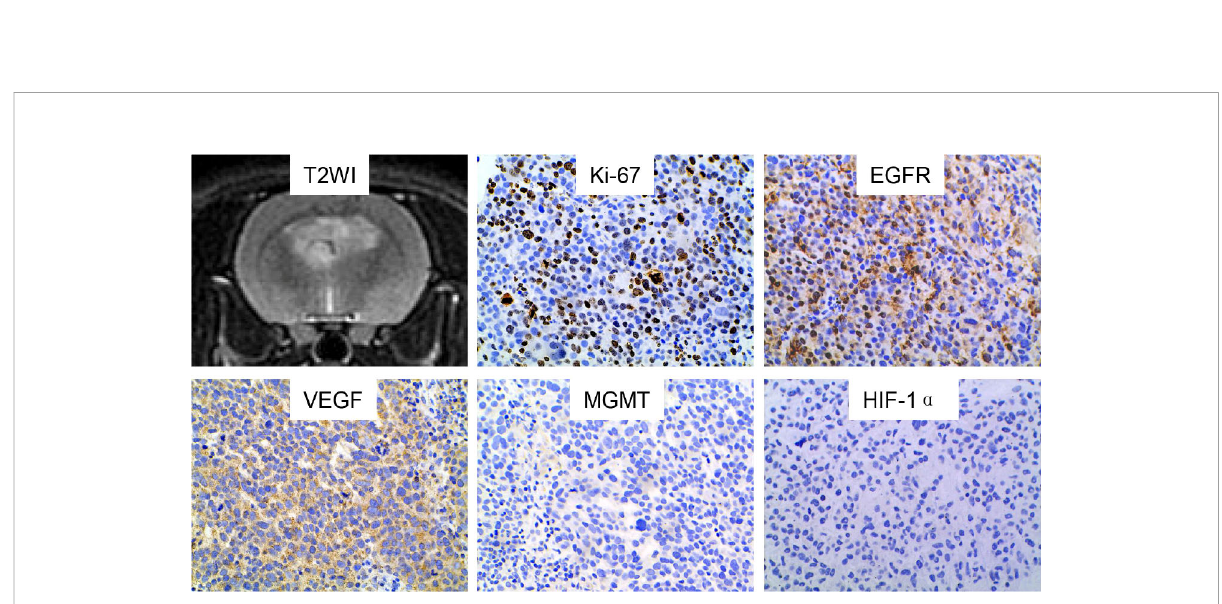
FIGURE 4 Characteristics of a representative GSC tumor on immunohistochemical staining. The tumor lesion showed positive expression of Ki-67, EGFR and VEGF. In contrast, negative expression was found for MGMT and HIF-1 a . GSC, glioma stem cell; T2WI, T2-weighted image; EGFR, epidermal growth factor receptor; VEGF, vascular endothelial growth factor; MGMT, O-6-methylguanine-DNA methyltransferase; HIF-1 a , hypoxia- inducible factor